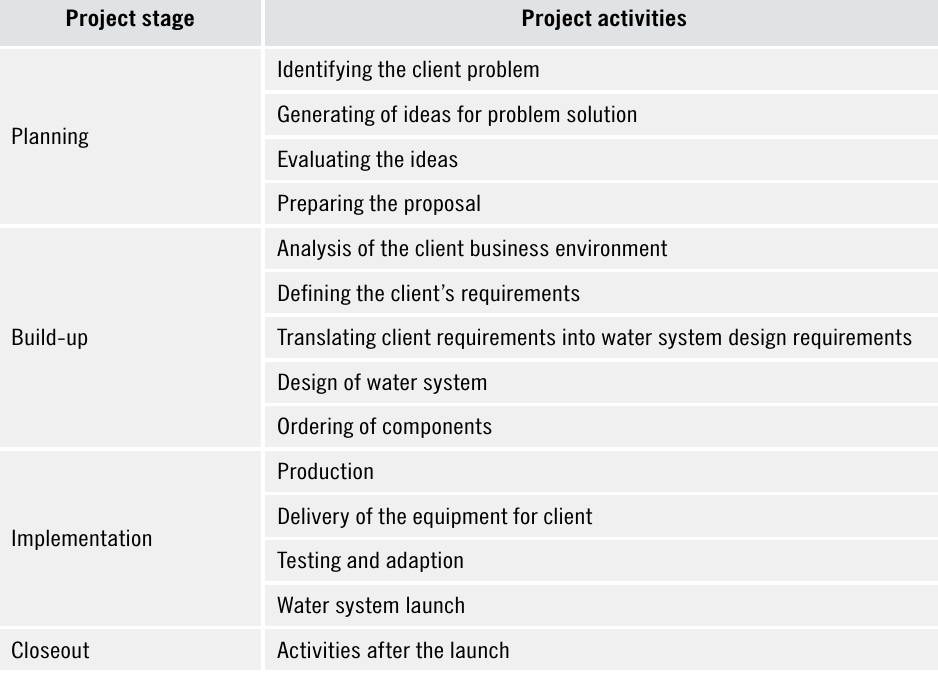
Table 6. Stages and activities of engineering service innovation